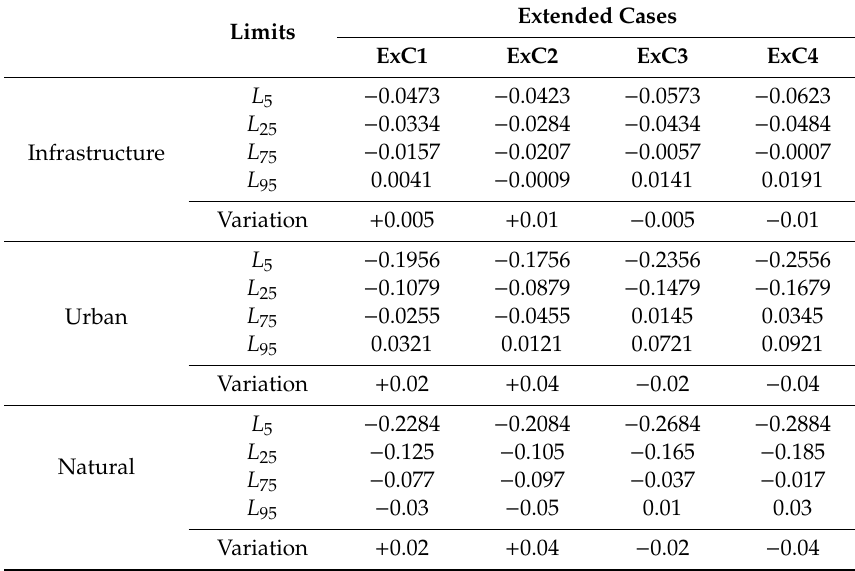
Table 10. Control limits (m) for the extended cases for the 3rd quality control.